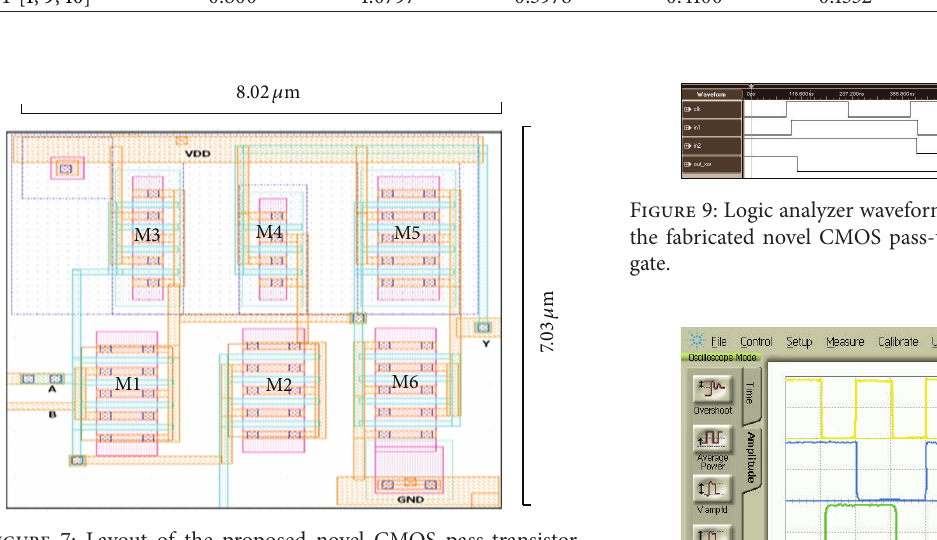
Figure 7: Layout of the proposed novel CMOS pass-transistor- based full-swing 2-input XOR gate.